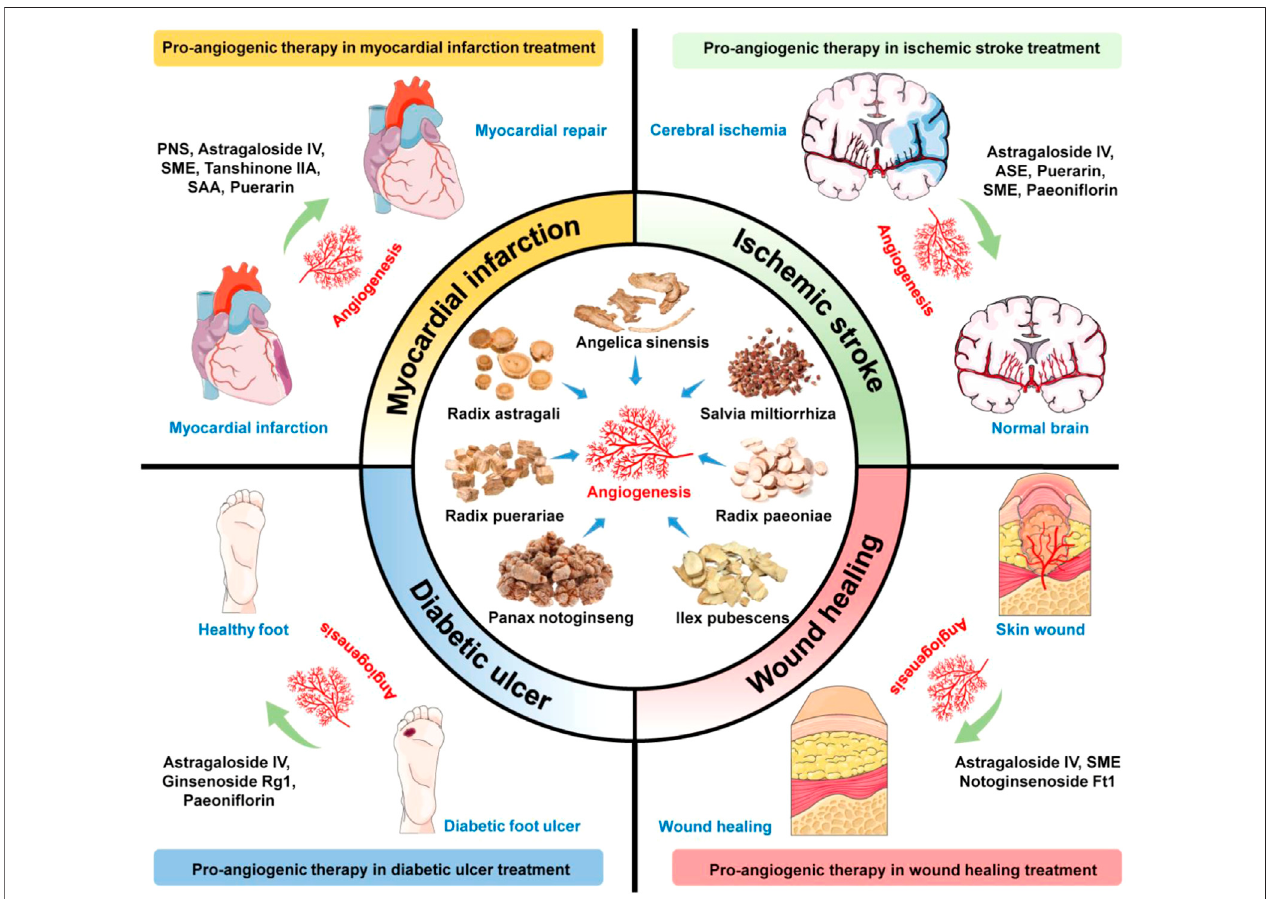
FIGURE 3 | Summarized fi ndings of pro-angiogenic phytochemicals for ischemic diseases, tissue repairing, and wound healing. Bioactive compounds or crude extractsof Panaxnotoginseng ,RadixAstragali, Salvia miltiorrhiza ,RadixPaeoniae, Ilexpubescens , Angelicasinensis ,and Radixpuerariae withpro-angiogenic activities show potential applications in treating ischemic stroke, myocardial infarction, diabetic ulcer, and wound healing. PNS, Panax notoginseng saponins; SME, Salvia miltiorrhiza extract; SAA, Salvianolic acid A; ASE, Angelica sinensis extract.